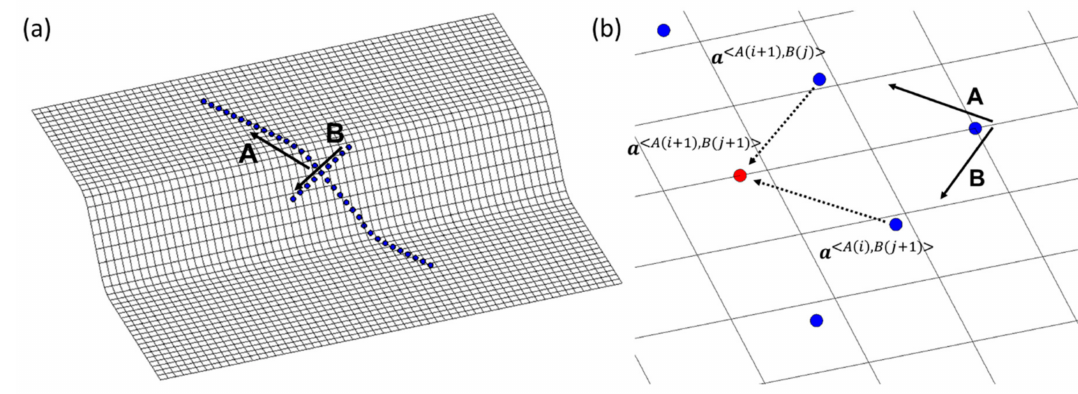
Figure 3. Node calculation, starting from the initial paths A and B ( a ), and for all further nodes ( b